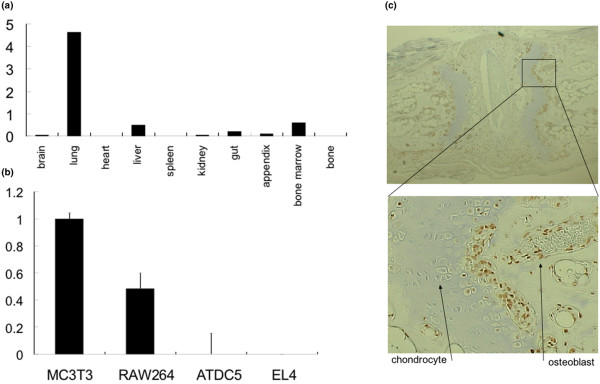
TWEAK expression in bone-related cell lines and the mouse bone tissue. (a) The indicated tissues were obtained from Balb/c mice, and RNA was extracted. Real-time PCR was then performed using specific primers for TWEAK and GAPDH. The ratio of each gene to that of GAPDH was calculated, and the value of 0.1 was assigned to the brain tissue. (b) RNA was extracted from MC3T3-E1, RAW264, ATDC5, and EL4 cells, and then real-time PCR was performed using specific primers for TWEAK and GAPDH. The ratio of each gene to that of GAPDH was calculated, and the value of 0.1 was assigned to MC3T3-E1 cells. (c) Immunohistochemical examination of the mouse bone tissue. Mouse tail bone tissues from Balb/c mice were stained with anti-TWEAK antibody. Representative images of weak enlargement (upper panel) and strong enlargement (lower panel) are shown. Positive staining is indicated as brown. GAPDH, glyceraldehyde-3-phosphate dehydrogenase; PCR, polymerase chain reaction; TWEAK, tumour necrosis factor-like weak inducer of apoptosis.